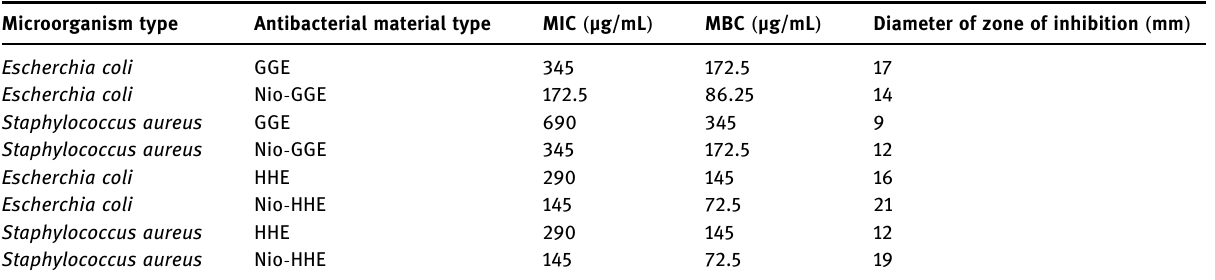
Table 6: Results of antibacterial activity of Nio - HHE and Nio - GGE on E. coli and S. aureus bacteria and their comparison with free form of extracts